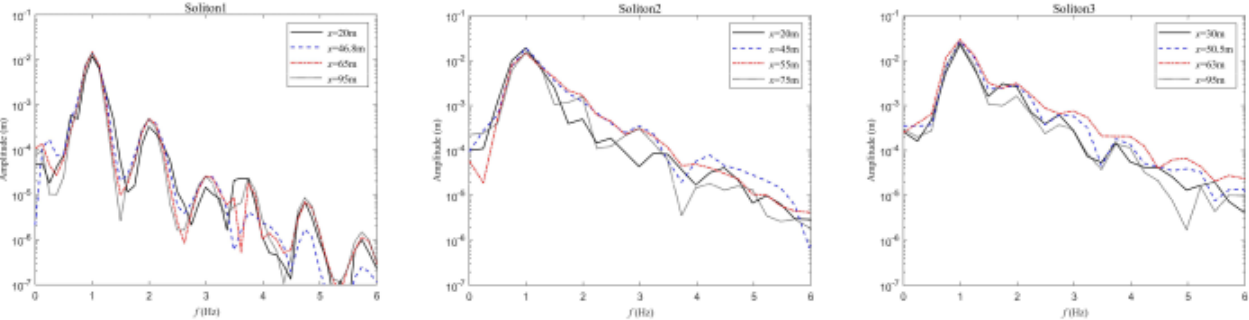
Figure 6. The wave amplitude spectra at different locations along the flume for Soliton 1 ( left ), Soliton 2 ( center ), and Soliton 3 ( right